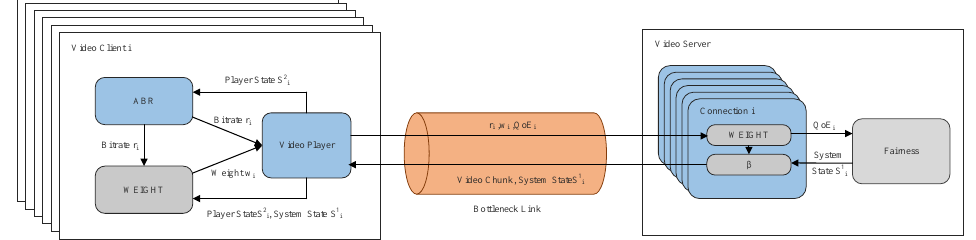
Figure 2. Active bandwidth allocation framework based on congestion